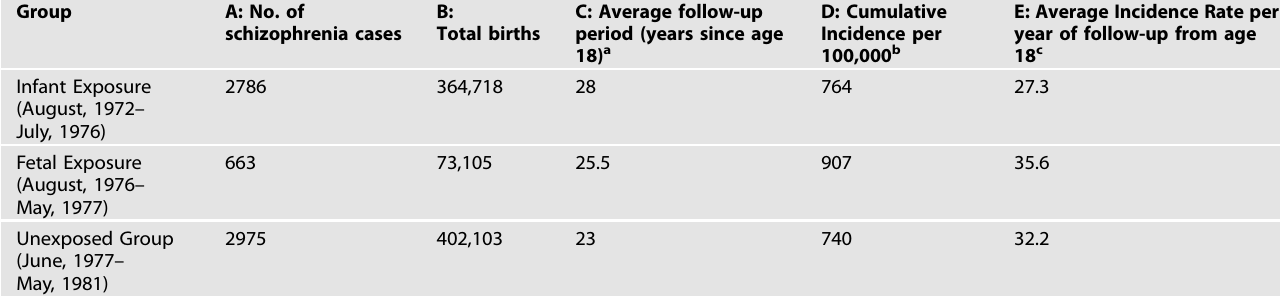
Table 4. Calculation of the average annual schizophrenia incidence by exposure